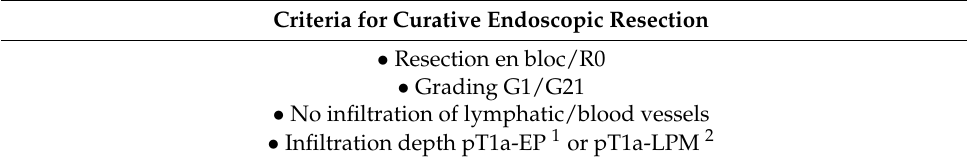
Figure 5. Endoscopic resection of early squamous cell cancer by endoscopic submucosal dissec- tion: ( a ) after chromoendoscopy with Lugol’s solution, the borders of the lesion are marked with coagulation points; ( b ) resection bed without any associated bleeding; ( c ) specimen on corkboard (after repeated staining with Lugol’s solution); ( d ) histopathology shows poorly differentiated pT1b squamous cell cancer (H&E stain, × 400). Table 4. Criteria for curative endoscopic resection of early squamous cell